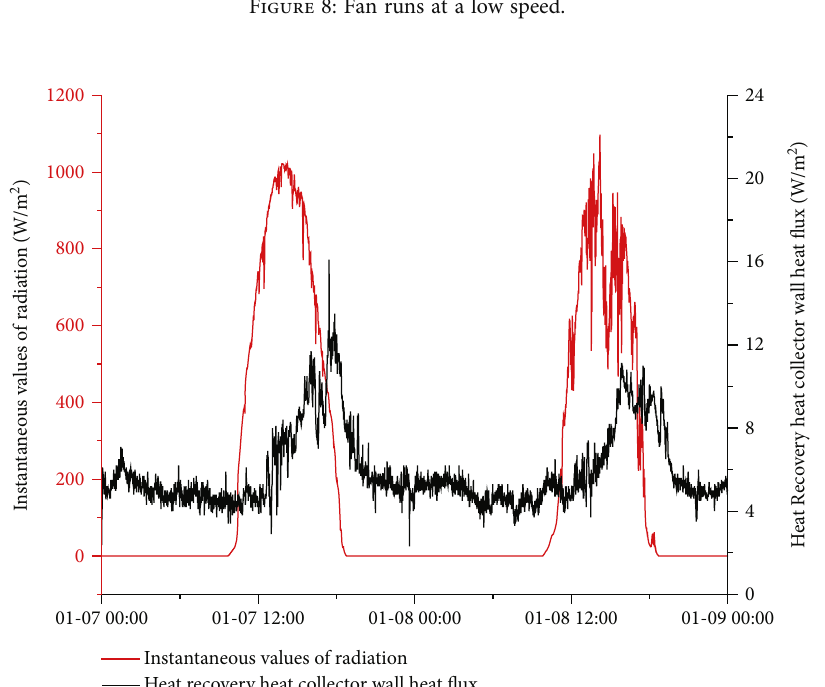
Figure 8: Fan runs at a low speed.